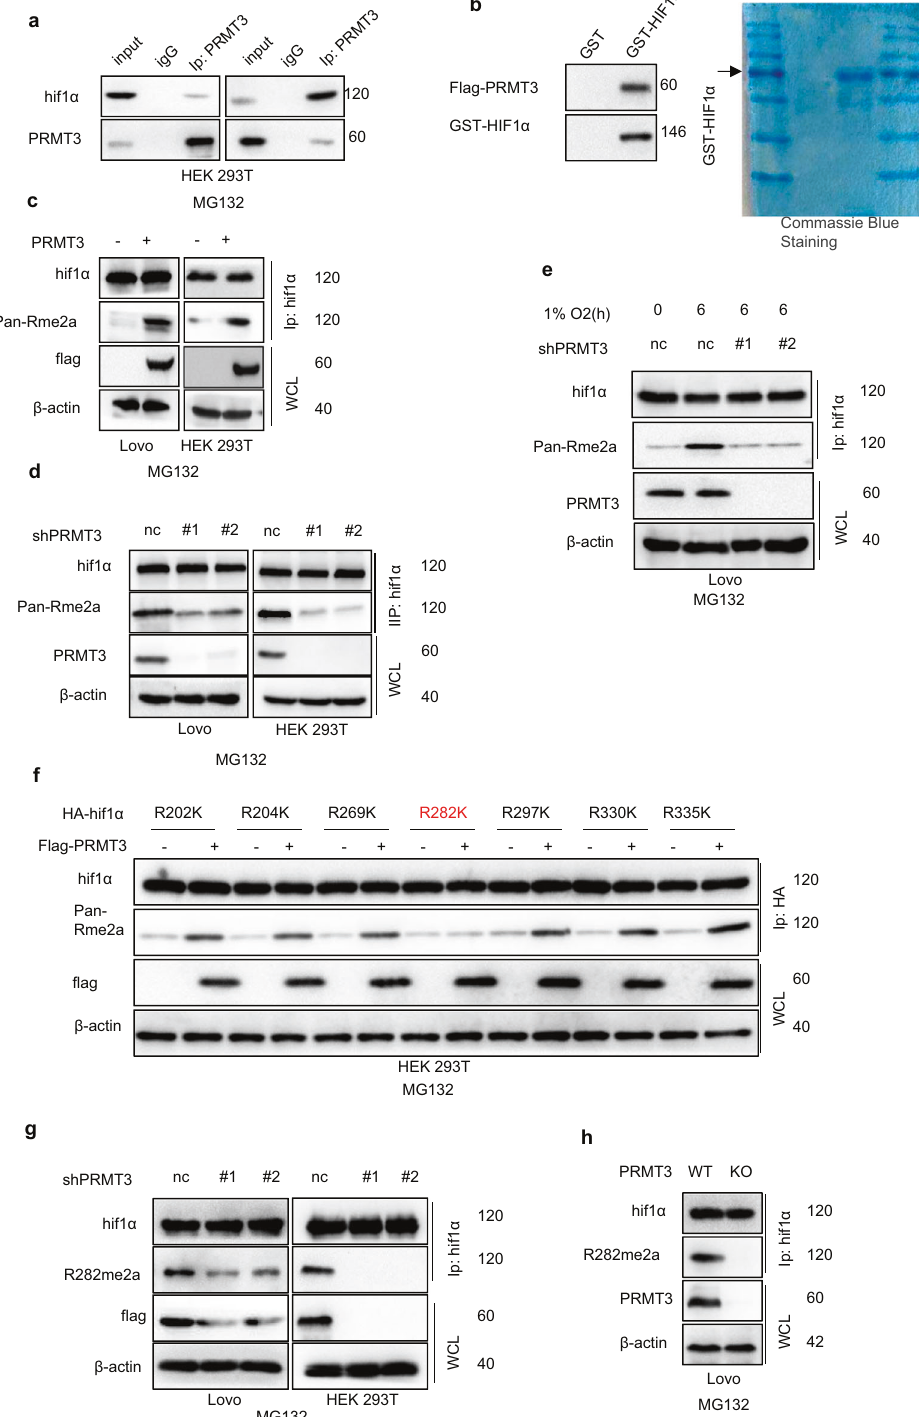
Fig. 5 HIF1 α R282 was methylated by PRMT3. a whole-cell lysis was collected for Co-IP analysis using identi fi ed antibodies, followed by immunoblots analysis. b Incubating GST-HIF1 α and PRMT3 protein, followed by GST-pulldown and immunoblots analyses. c Co-IP and immunoblots analysis to investigate the asymmetric demethylation level of HIF1 α of cells ectopic expressing vector or PRMT3. d Silencing PRMT3 expression using lentivirus, Co-IP and immunoblots analysis to investigate the asymmetric demethylation level of HIF1 α . e Silencing PRMT3 expression using lentivirus; Co-IP and immunoblots analyses to investigate HIF1 α asymmetric demethylation level with or without hypoxia. f HEK 293T cells were respectively transfected with 7 HA-tag methylation-de fi cient variants of HIF1 α and vector or PRMT3 plasmid; Co-IP and immunoblots analyses to investigate HIF1 α asymmetric demethylation level under MG132 treatment. g Silencing PRMT3 expression using lentivirus; Co-IP and immunoblots analysis to assess R292me2a level of HIF1 α . h Knocked out PRMT3 expression using lentivirus; Co-IP and immunoblots analysis to assess R292me2a level of HIF1 α . All immunoblots were conducted three times, affording same